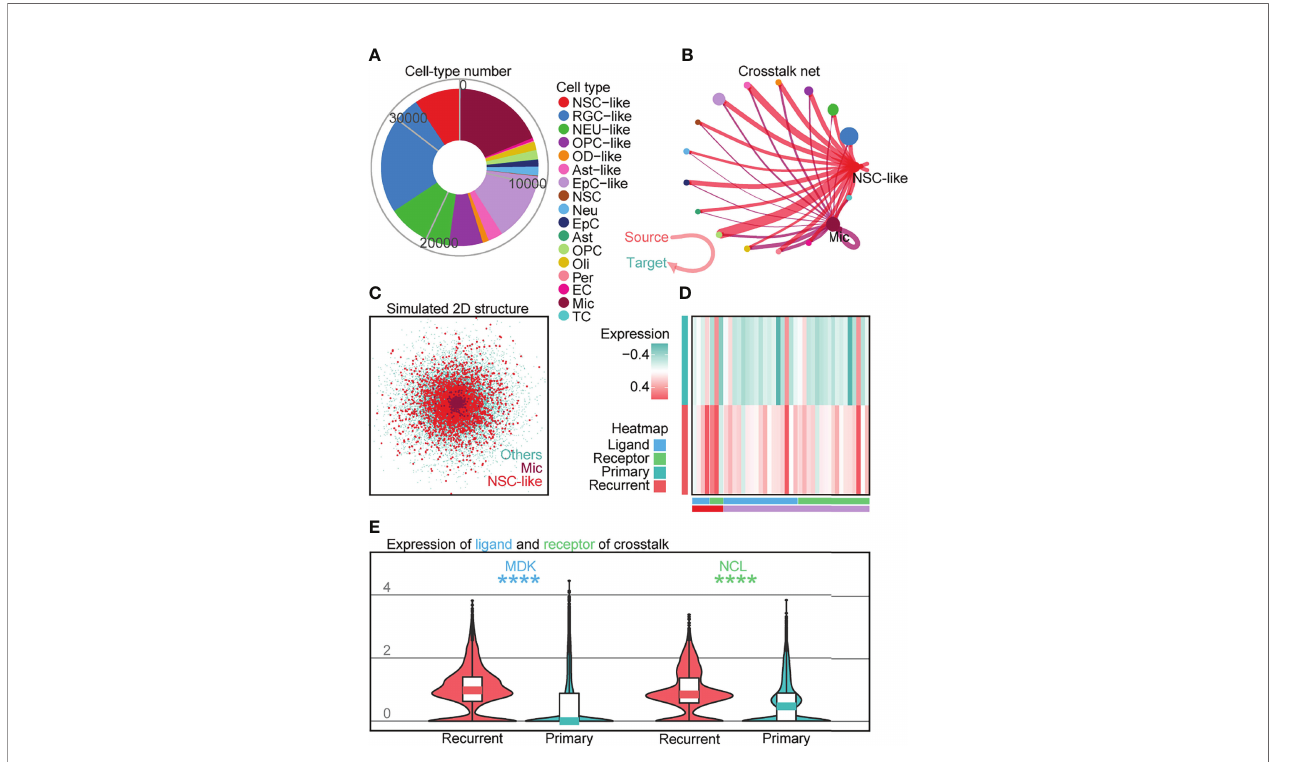
FIGURE 5 | Crosstalk analysis reveals cell – cell interactions implicating immune cell populations in recurrent EPN. (A) Cell numbers of all cell types in four EPN samples. (B) Crosstalk net analyzed by CellChat. Individual lines represent the crosstalk from source to target cells, highlighting interactions from NSC-like cells and Mic to other cell types. Related to Supplementary Figures S8A, B . (C) Simulated 2D spatial structure showing overlap of Mic and NSC-like cell populations by CSOMAP (34). Related to Supplementary Figure S8C . (D) Heatmap of ligands or receptors with signi fi cantly higher expression in recurrent samples compared to primary samples, colored by cell type and gene class (ligands or receptors) using published single-cell transcriptomes of 36 EPN samples (5, 6). (E) Expression of MDK (ligand) and NCL (receptor) between recurrent and primary samples of 36 EPN patients (5, 6) ( p < 0.0001; Mann – Whitney test).The "*" means signi fi cant difference (p-value): * p < 0.05; ** P < 0.01; *** p < 0.001; **** p <